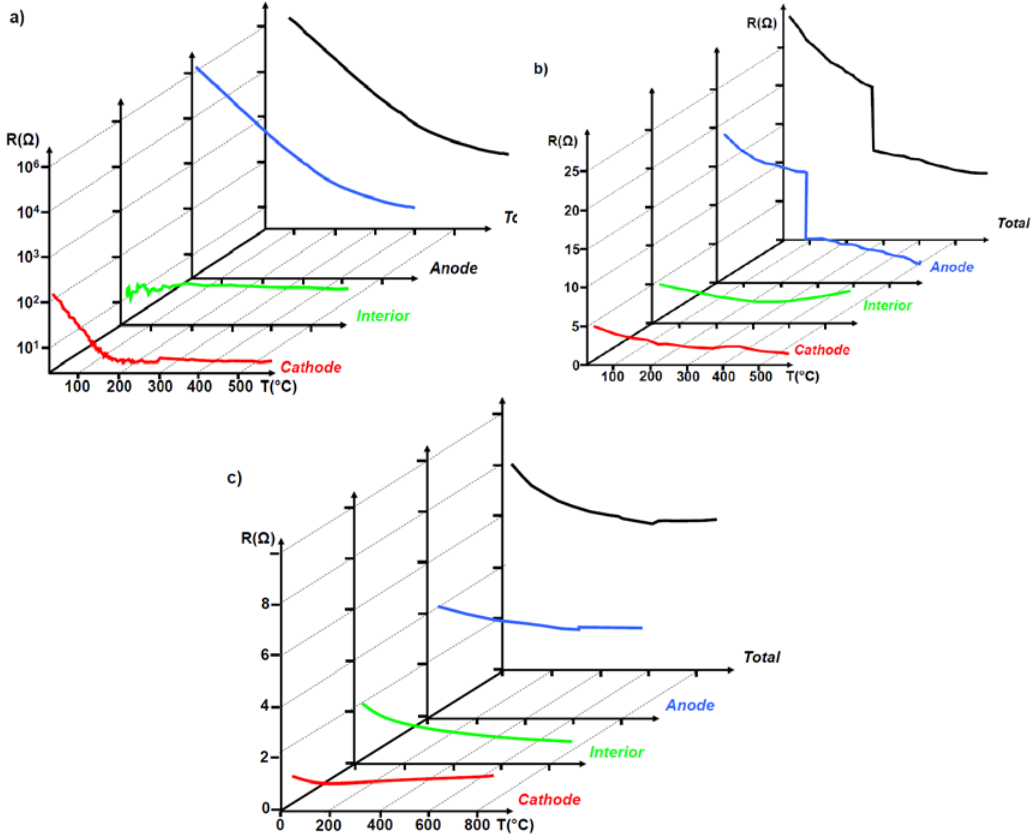
Figure 53. The thermal dependence of resistance for the cathode, interior and anode regions of the TiO 2 sample after ( a ) ‘soft’; ( b ) ‘heavy’; and ( c ) ‘extra heavy’ electroforming. Adapted from [53].